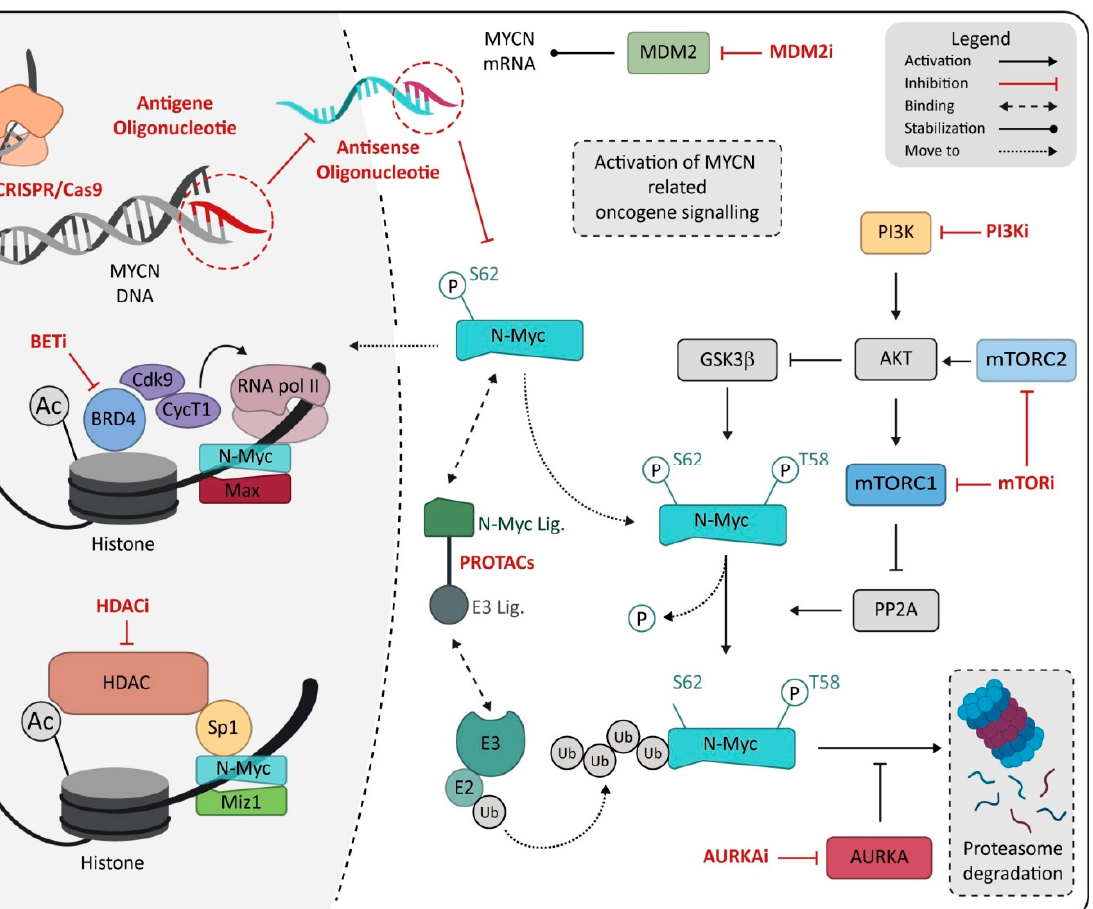
Figure 2. Schematic representation of drugs directly or indirectly targeting MYCN. Drugs are marked in red and reported as class, named on mechanism of action. Abbreviation: MDM2, murine double minute 2; PI3K, Phosphoinositide 3-kinases; PI3Ki, Phosphoinositide 3-kinases inhibitor; BETi, bromodomain and extra-terminal domain family inhibitor; BRD4, bromodomain-containing protein 4; mTORC1, mammalian target of rapamycin complex 1; mTORC2, mammalian target of rapamycin complex 2; mTORi, mammalian target of rapamycin inhibitor; PROTACs, proteolysis-targeting chimeras; MIZ1, MYC-interacting zinc-finger protein 1; HDAC, histone deacetylase; HDACi, histone deacetylase inhibitor; E3, E3 ubiquitin ligase; E2, E2 ubiquitin-conjugating enzyme; AURKA, Aurora kinase A; AURKAi, Aurora kinase A inhibitor; Ub, ubiquitin.